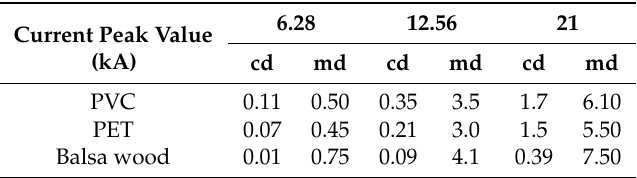
Table 2. Damage radius